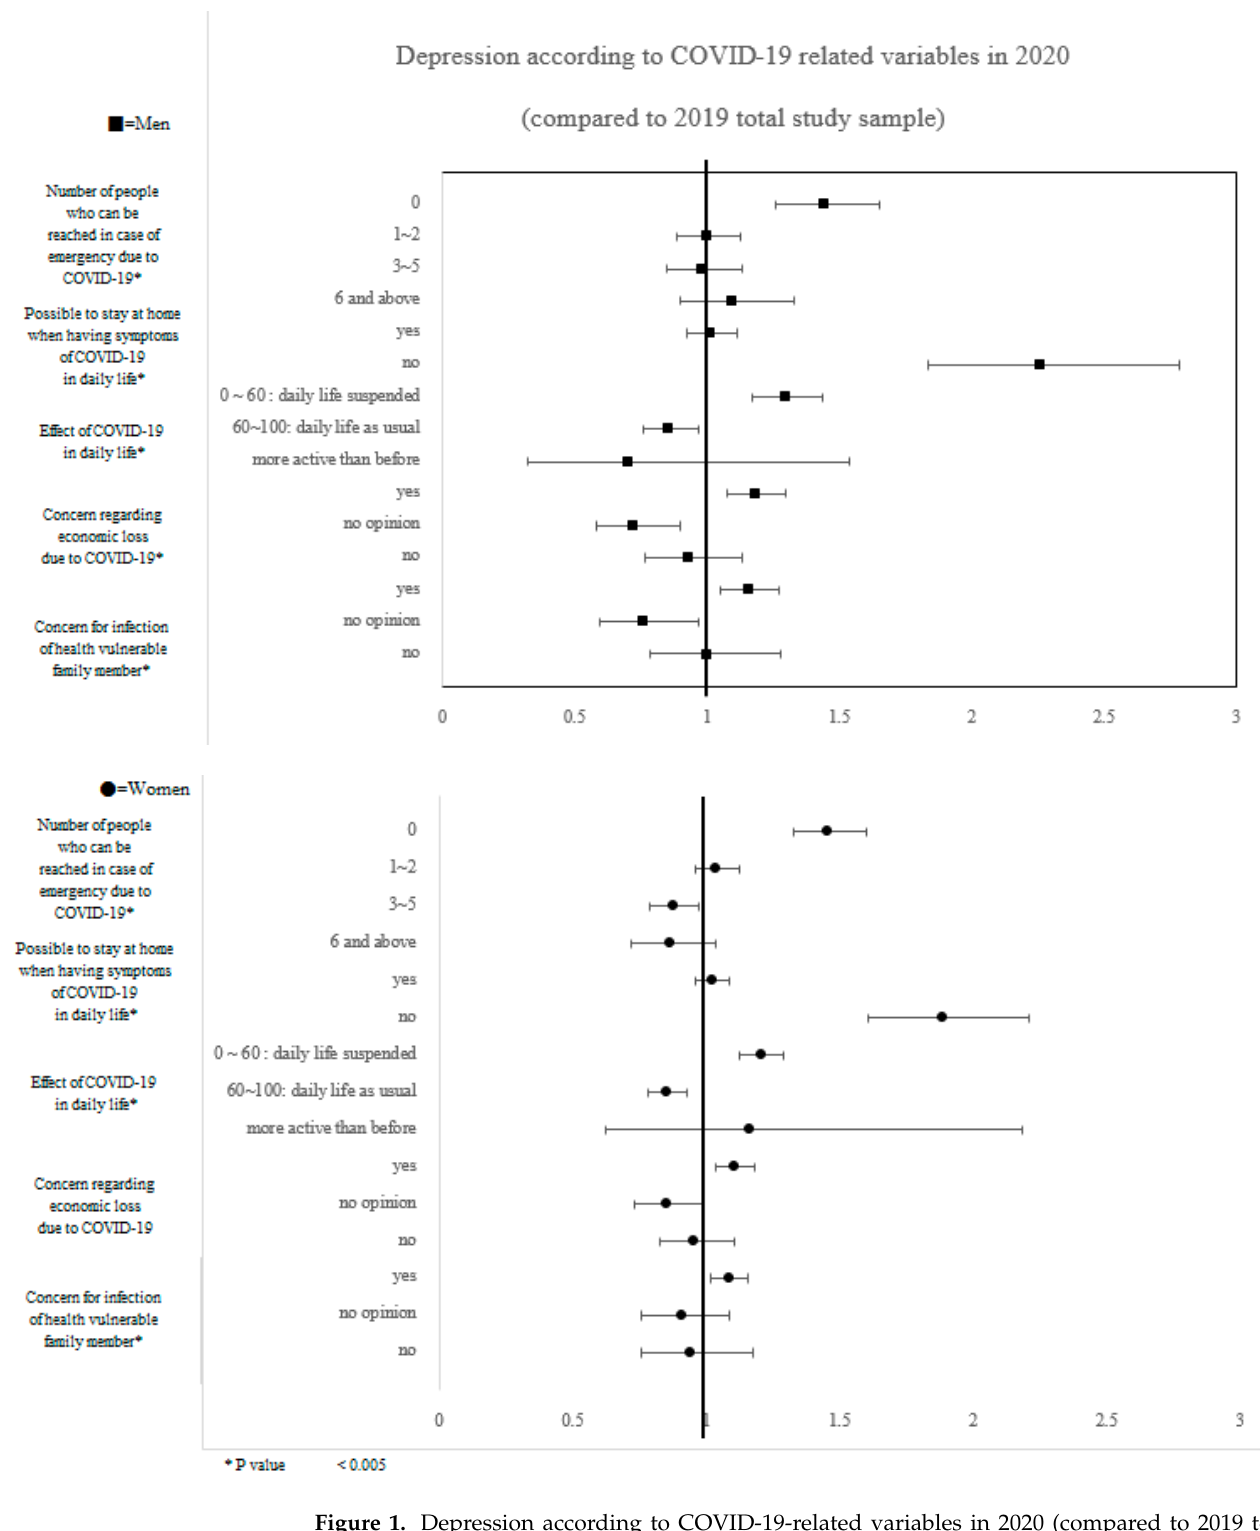
Figure 1. Depression according to COVID-19-related variables in 2020 (compared to 2019 total study sample).